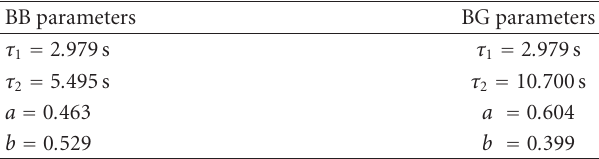
Table 2: Parameters of the hypoexponential